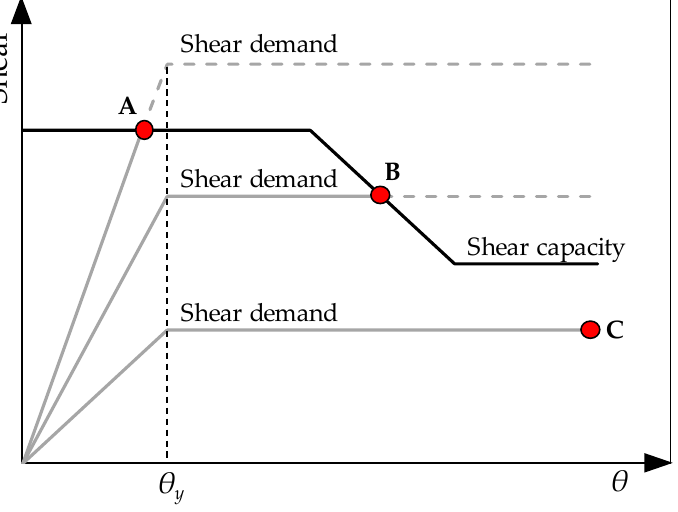
Figure 11. Shear-bending interaction and failure modes.